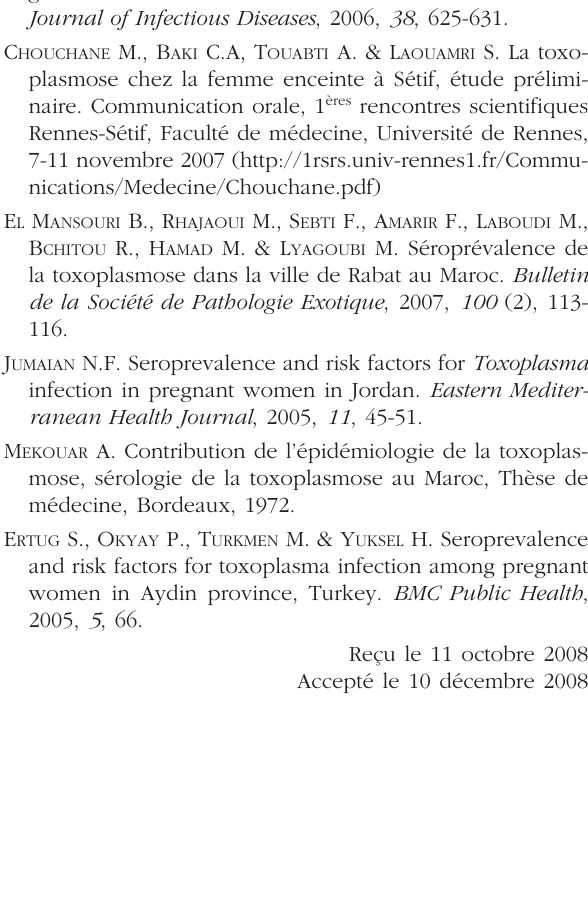
gondii in Sweden Estonia and Iceland.